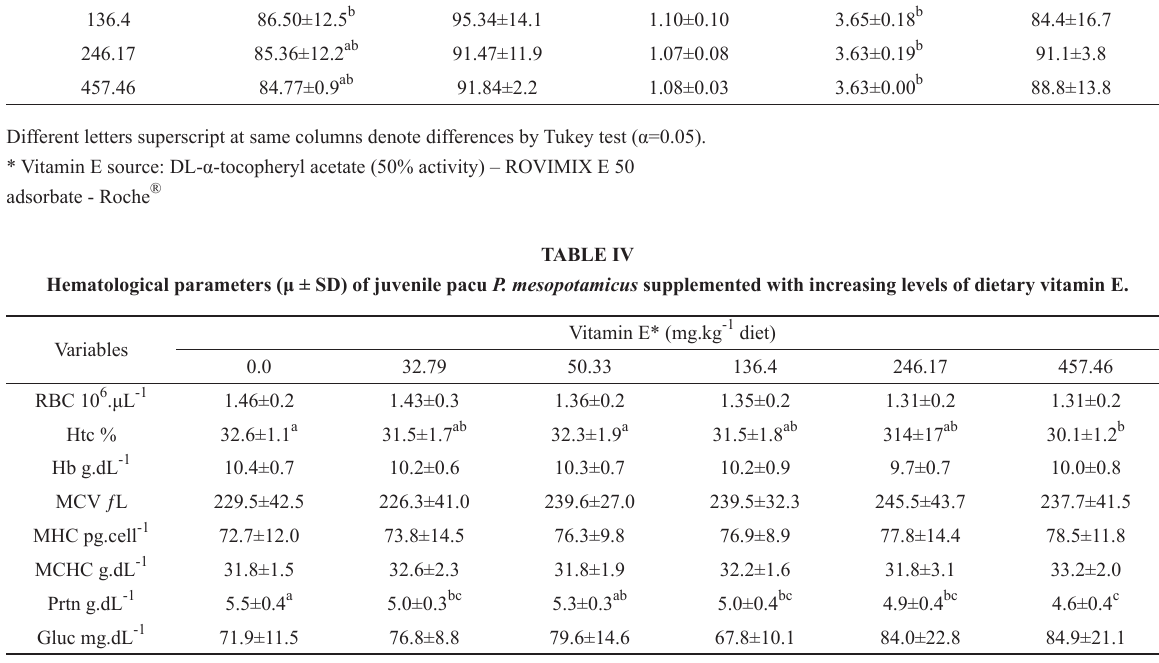
Different letters superscript at same columns denote differences by Tukey test